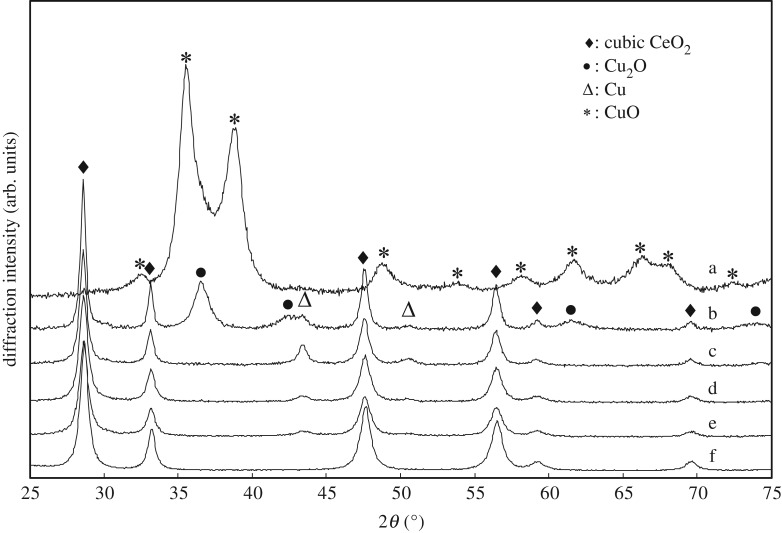
XRD patterns (CuO)x(CeO2)1−x powder after 18 h milling (x=: (a) 1, (b) 0.8, (c) 0.7, (d) 0.5, (e) 0.2, (f) 0).